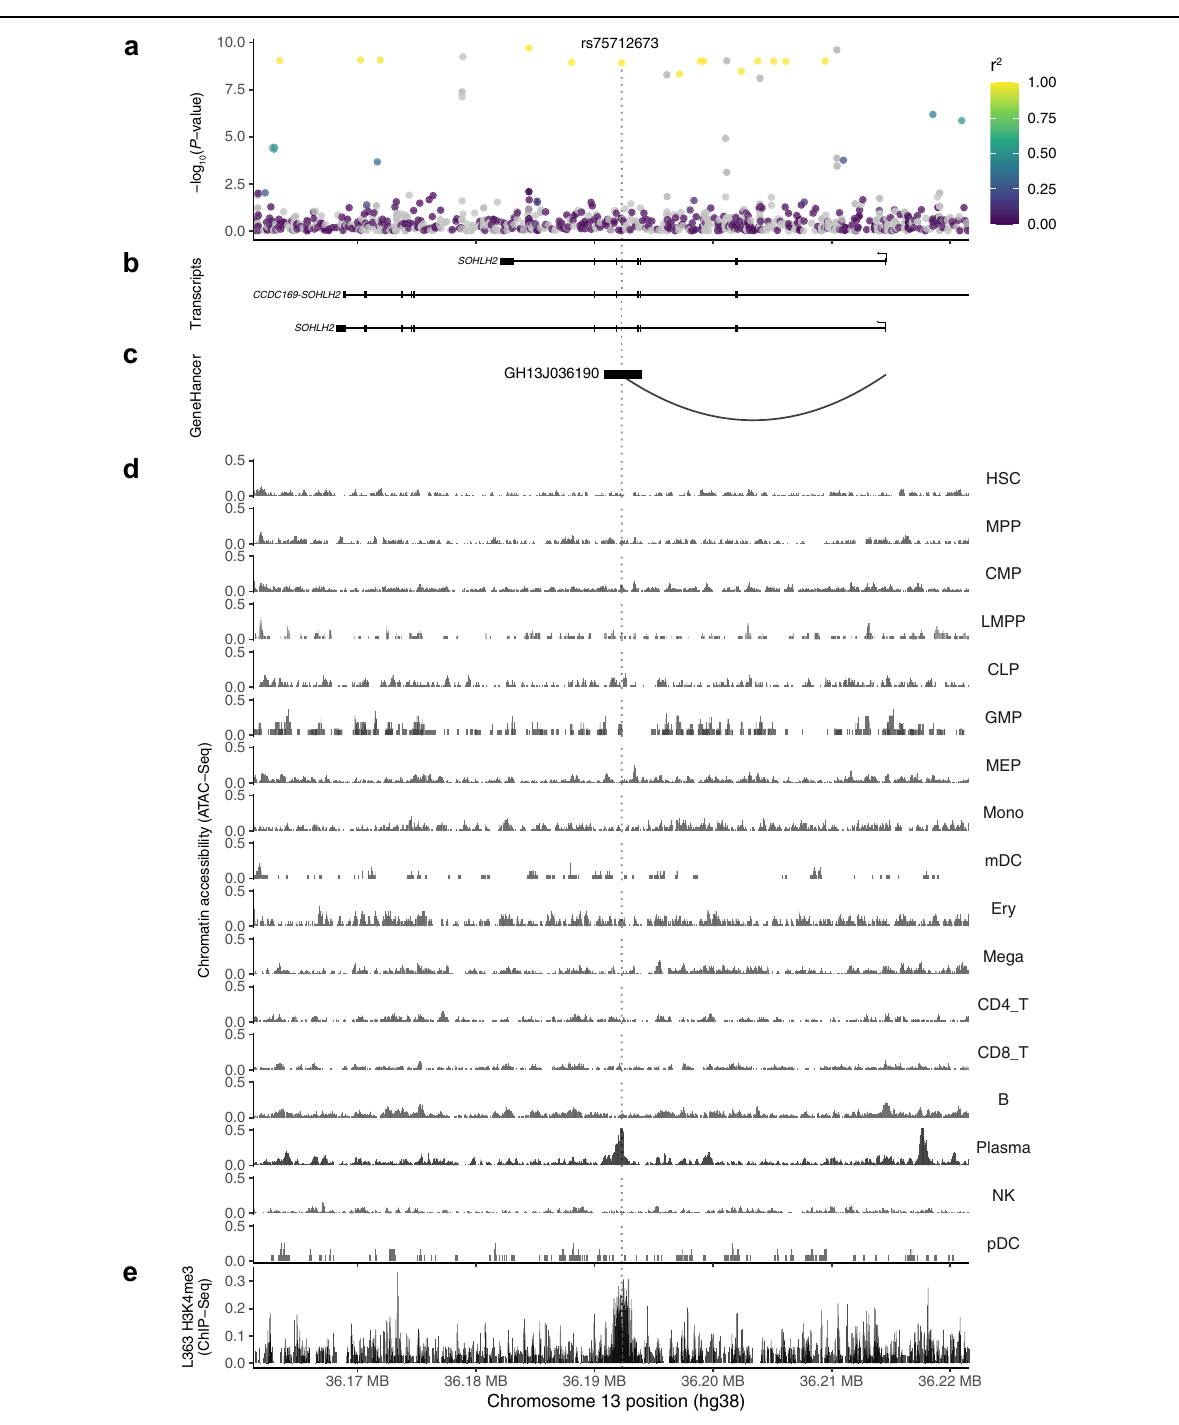
Fig. 1 Region plots of the 13q13.3 association. a − log 10 ( P ) for association in the meta-analysis of the four Nordic discovery sets ( y -axis). The colour re fl ects the extent of LD with the 13q13.3 lead variant rs200203825. b Genes mapping to the region of association, based on NCBI build 38 of the human genome. c Chromatin looping interaction between rs75712673 and the SOHLH2 promoter, detected in promoter-capture HiC in transformed fi broblasts, data from GeneHancer d ATAC-seq chromatin accessibility across primary blood cell types; rs75712673 maps to a region that is selectively open in plasma cells. e Chromatin immunoprecipitation and sequencing (ChIP-seq) data for H3K4me3 histone mark in L363 MM plasma cell